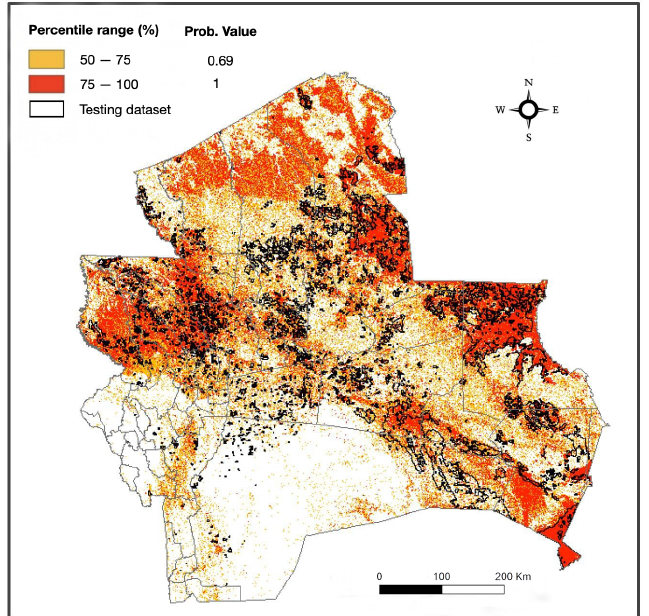
Figure 8. Performance evaluation of the RF outputs (Percentile range and corresponding Probability values) for the department of Santa Cruz, assessed by using the testing dataset (2017–2019 burned